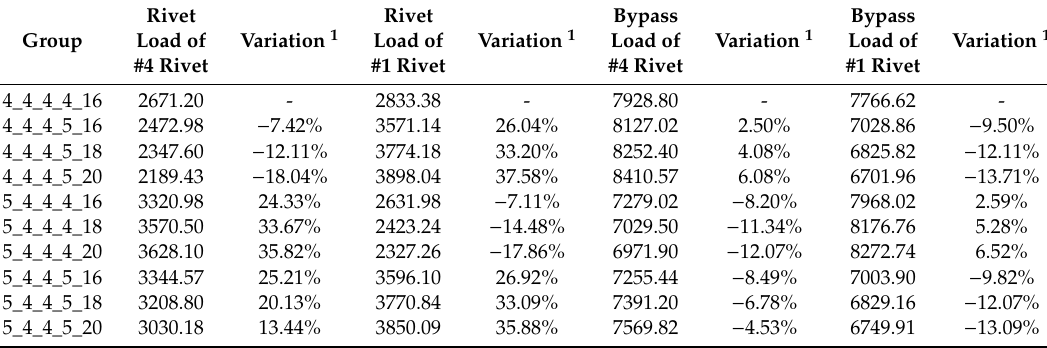
Table 5. The rivet loads and bypass loads of 1# and 4# rivets (unit: